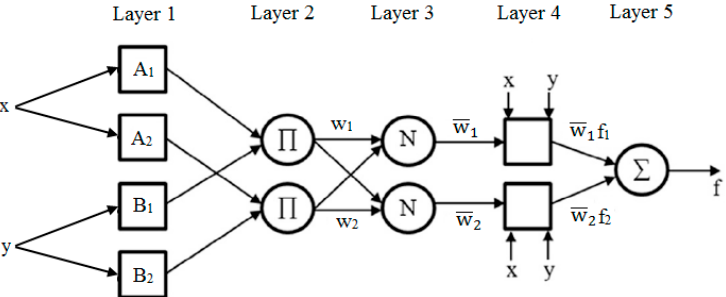
Figure 3. The architecture of the adaptive neuro-fuzzy inference system (ANFIS) model with two inputs, one output, and two rules.